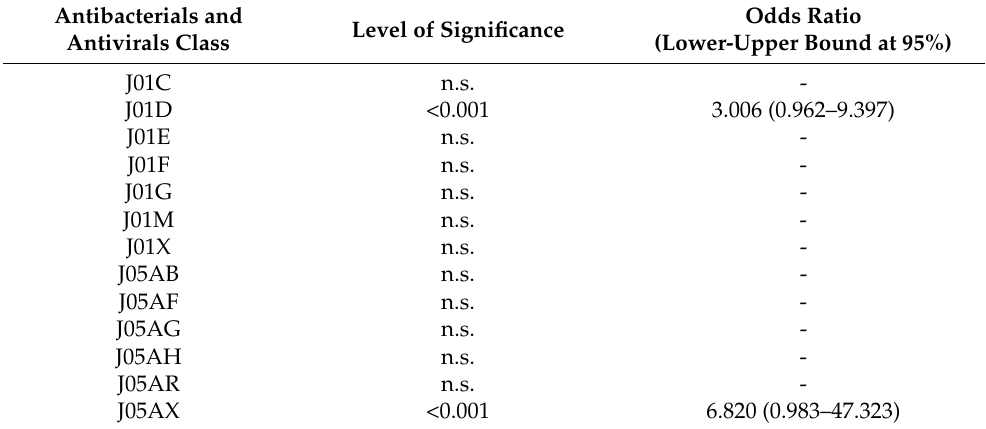
Table 4. Antibacterials and antivirals class and its effectiveness in improving patients’ outcome during hospitalization.